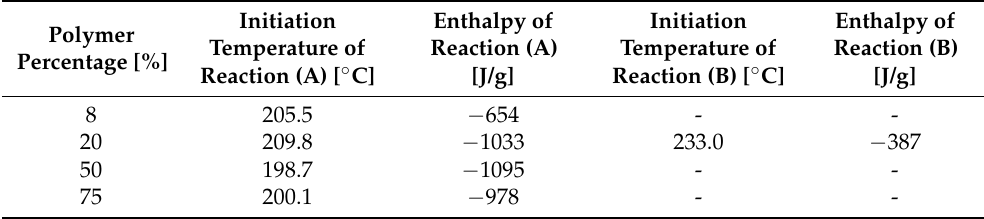
Figure 10. DSC analysis of pure AN, pure PA, and their mixture (20%), heat rate 10 °C/min. En- thalpy of the mixture decomposition process Δ H A = –1033 J/g, Δ H B = –387 J/g (values of A and B reactions are given in Table 5).